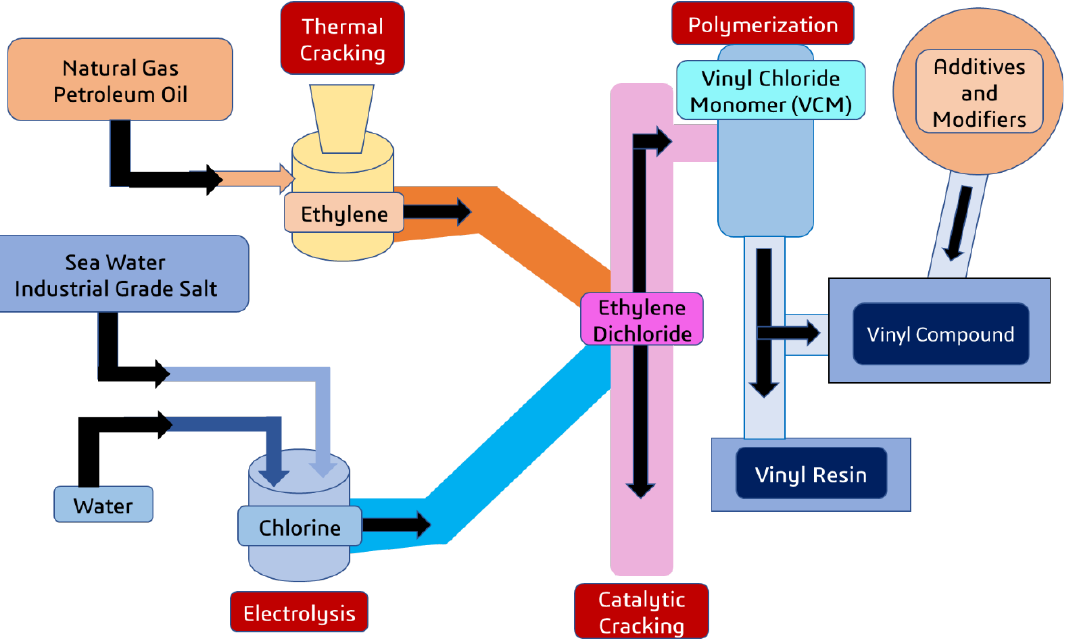
Figure 6. The generalized production process of vinyl resin [29].